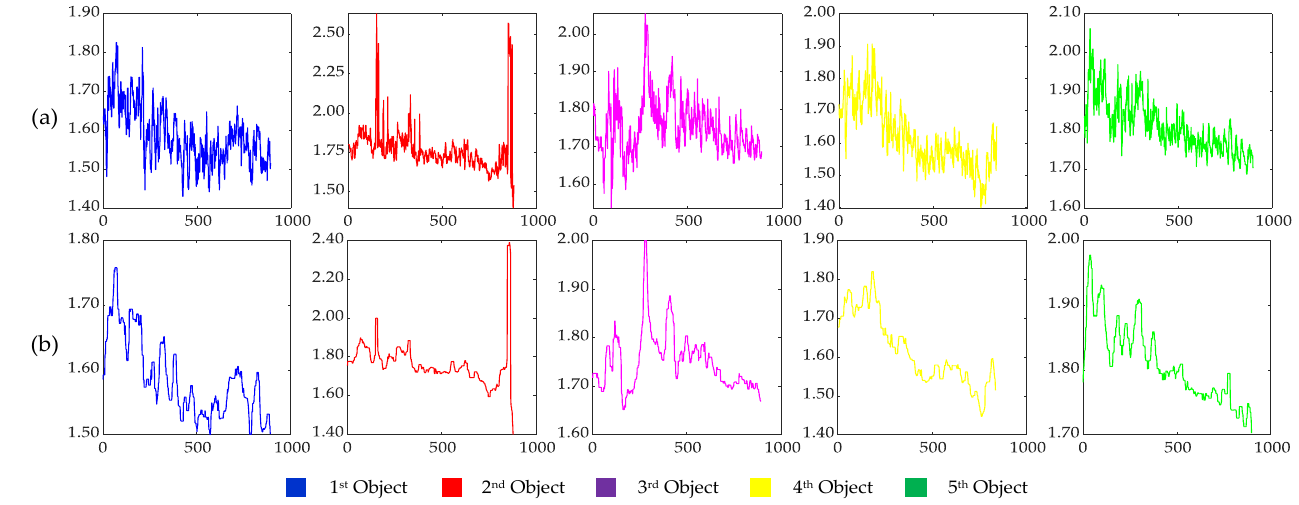
Figure 11. The width of moving objects. ( a ) The original calculation results of the object width; (b) the calculation results of the object width filtered by median filtering. The ordinate is the width (m), and the abscissa is the video frame number.